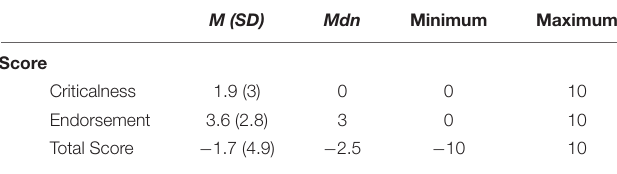
TABLE 5 | Descriptive statistics for separate scores of criticalness and endorsement and total score of criticalness relative to